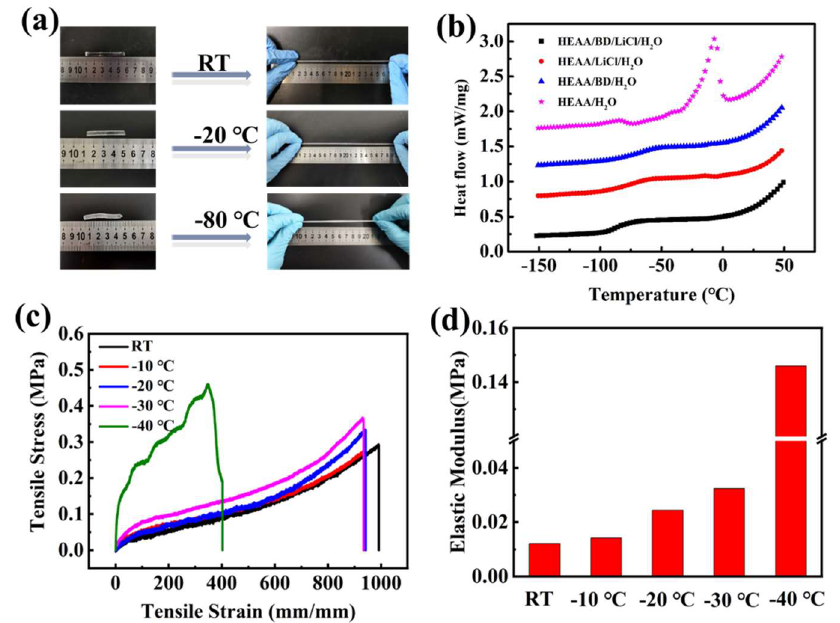
Figure 2. ( a ) LiCl/p(HEAA− co −BD) hydrogel stretched under RT, −20 °C and −80 °C; ( b ) DSC curves of hydrogels with different components; ( c ) Stress–strain curves and; ( d ) Elastic modulus of LiCl/p(HEAA− co −BD) hydrogel at RT, −10 °C, −20 °C, −30 °C, and −40 °C, respectively .